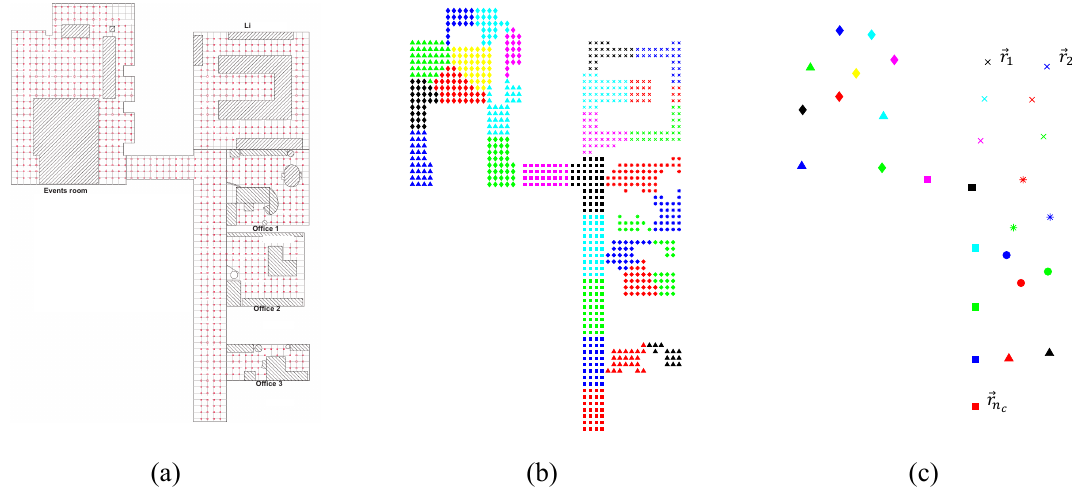
Figure 3. Example of an indoor map and a compression of the information. ( a ) Positions where the images were captured. ( b ) Result of the clustering process. ( c ) Each cluster is reduced to one